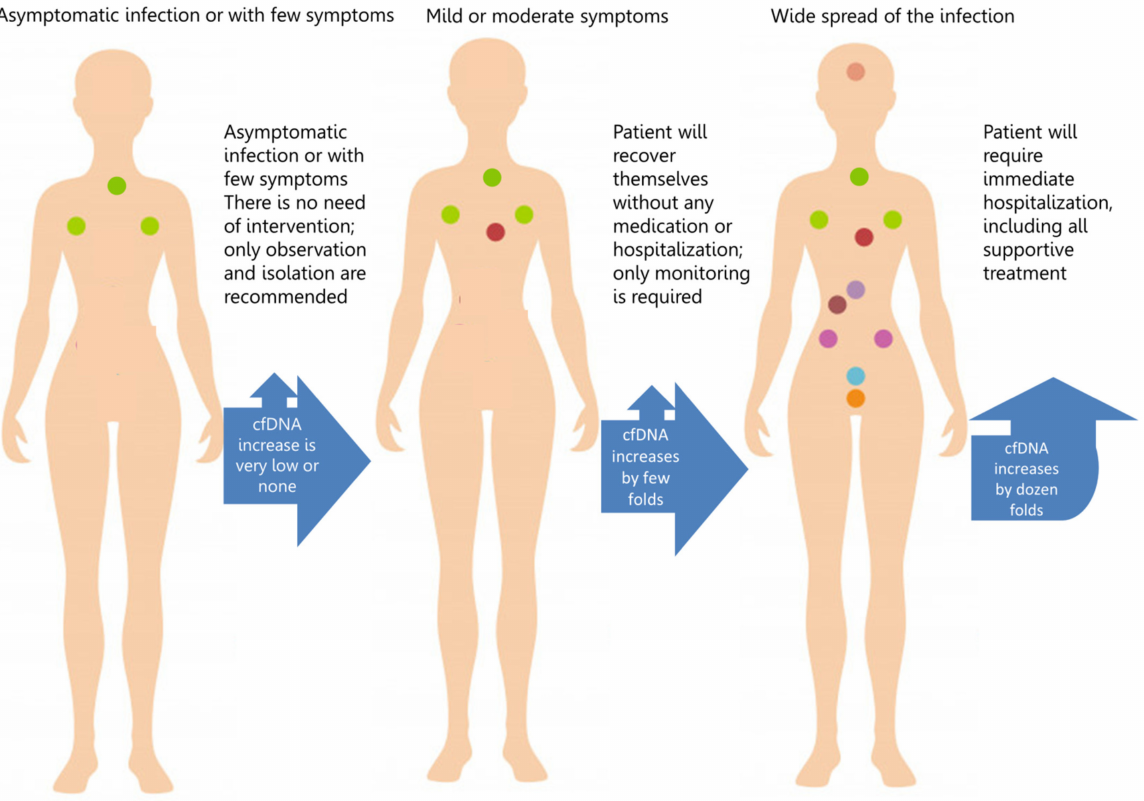
Figure 2. COVID-19 management based on cell-free DNA analysis [92,93]. Schematic representation of how to deal with a patient, based on the level of cfDNA, reflecting the current condition and the stage of disease in the COVID-19 patient. Filled spots represent the potential cfDNA releasing organ (details shown in Figure